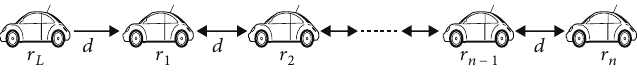
Figure 1: Bidirectional topology of the vehicle